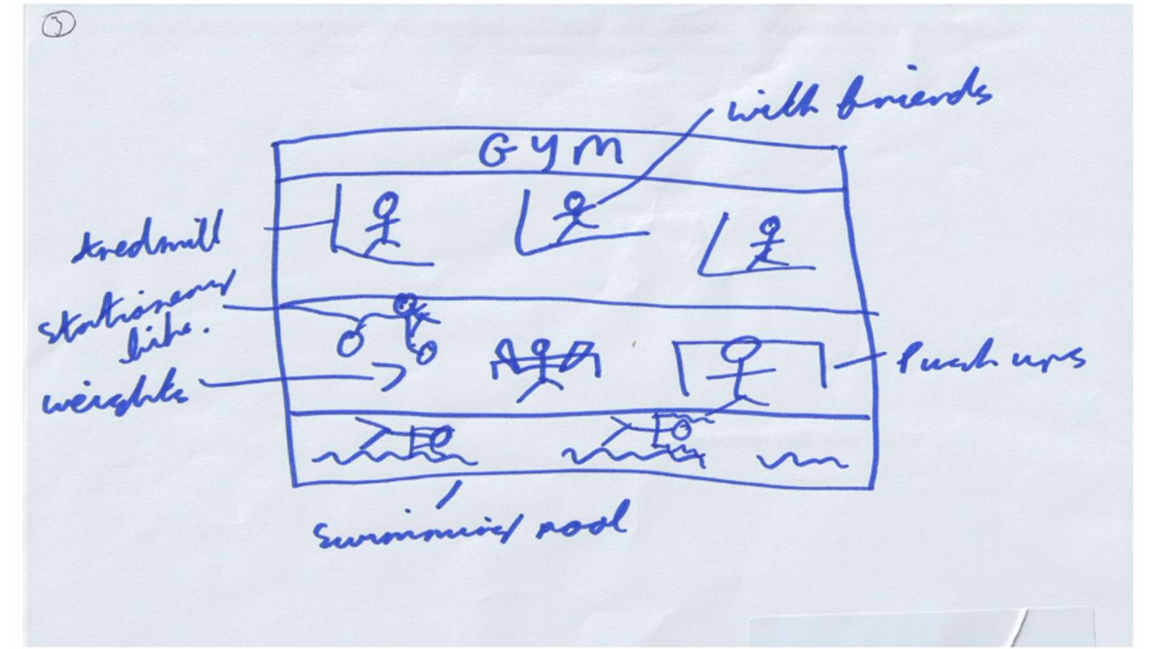
Figure 6. Drawing illustrating co-participation in physical activity with friends. (ID30). “You can like, use the gym here (school), but you probably couldn’t do it with your mates and that. They (teachers) don’t trust us I don’t think. In a gym is sound, no teachers so you can just train properly.”